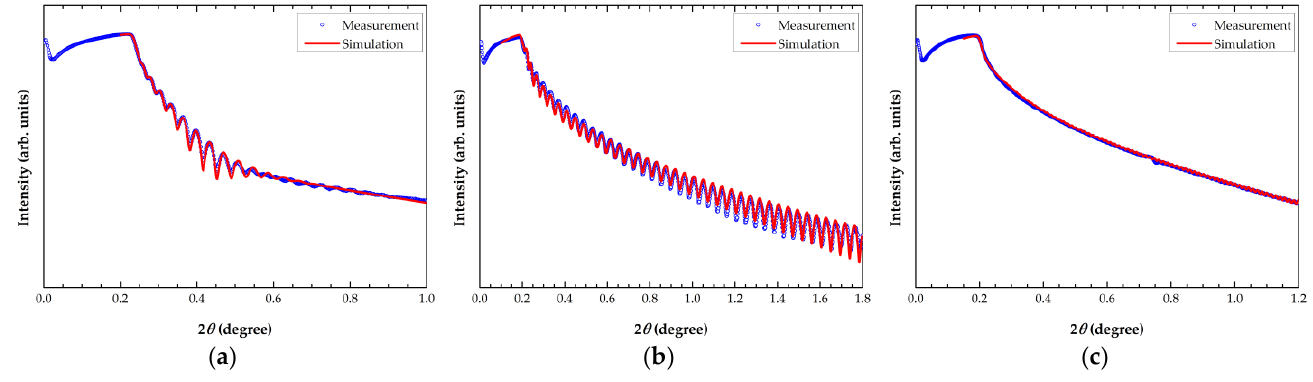
Figure 4. XRR measurement results: ( a ) 100 nm Al, ( b ) 100 nm a-SiC, and ( c ) 300 nm a-SiC.